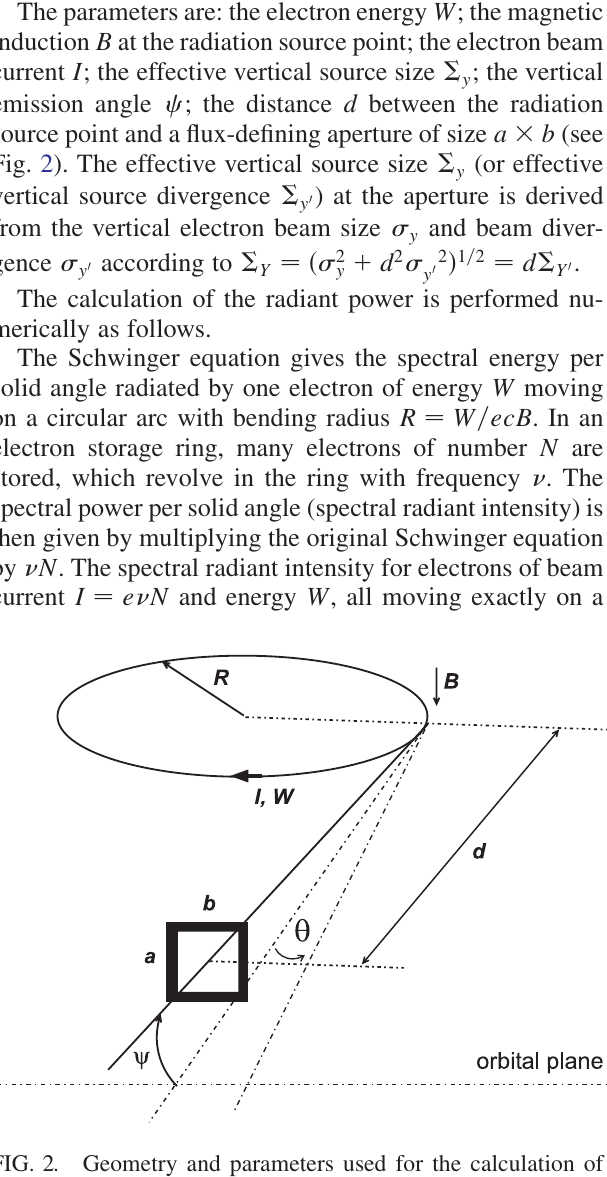
FIG. 2. Geometry and parameters used for the calculation of the radiant power emitted from a bending